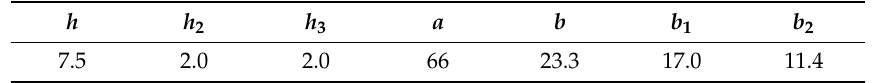
Table 1. Main normalized dimensions of the carbon/epoxy fiber reinforced polymer pane 1 .